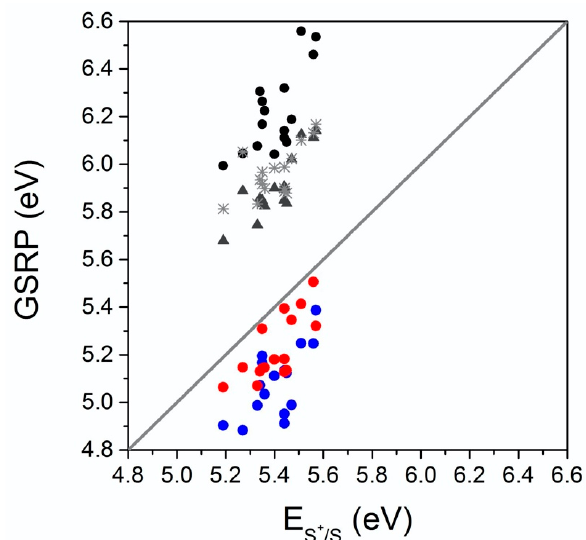
Figure 3. Computed ground state redox potential (GSRP) values (GSRP b-d in Table S3) vs. experimental E S+/S values. The y = x diagonal is reported as a reference. Black circles: MPW1K/6-31+G*//MPW1K/6-31+G* values in gas-phase; blue circles: MPW1K/6-31+G*//MPW1K/6-31G* values in DCM; red circles MPW1K/6-31+G*//MPW1K/6-31+G* values in dichloromethane (DCM); grey triangles: minus the value of the highest occupied molecular orbital energies, − ε (HOMO) in gas-phase; grey asterisks: − ε (HOMO) in DCM.